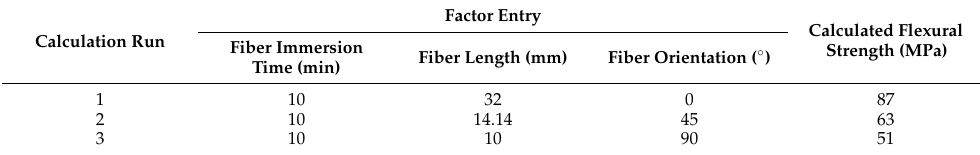
Table 6. Proposed fiber length for maximizing flexural strength.